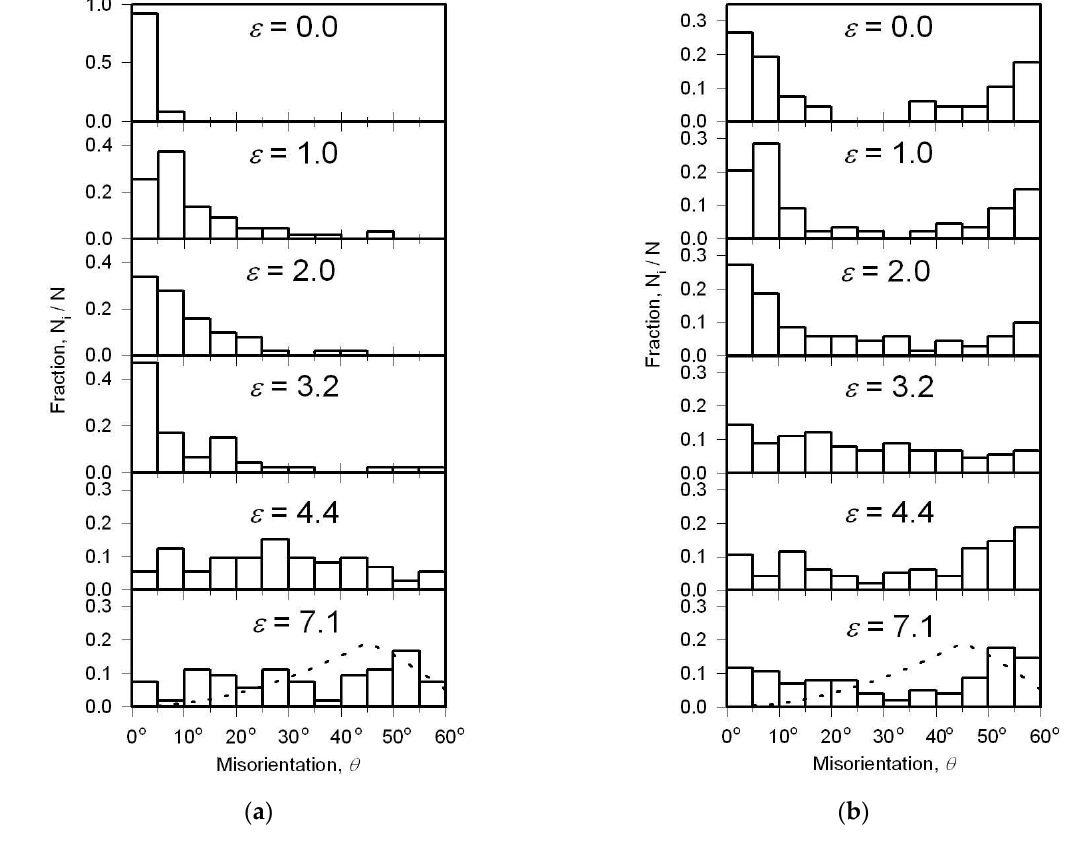
Figure 28. Misorientation distributions for the (sub)grain boundaries evolved in Fe-22%Cr-3%Ni ( a ) and Fe-18%Cr-7%Ni ( b ) stainless steels after bar rolling/swaging to various strains [29].